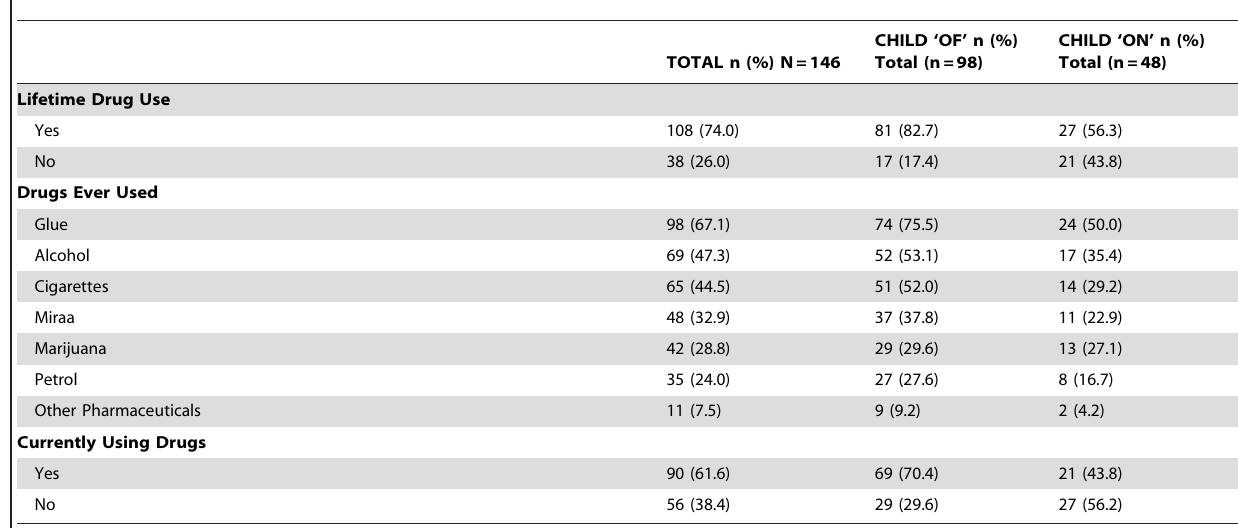
Table 1. Prevalence of lifetime and current drug use amongst a 146 street-involved children and youth in Eldoret,